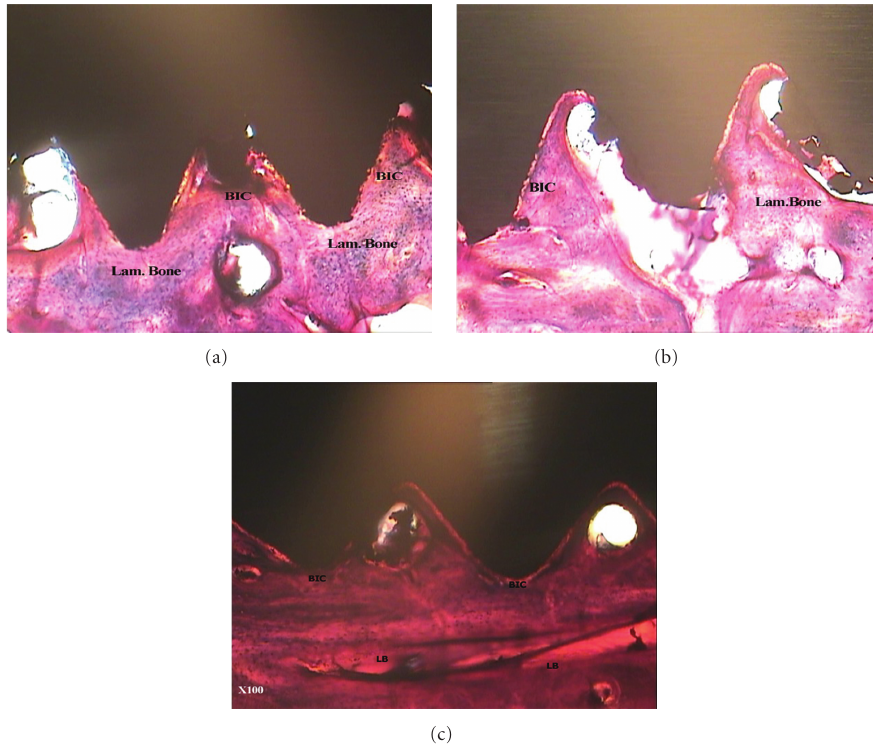
Figure 2: Photomicrographs of bone-to-miniscrew contact in di ff erent groups: (a) immediate orthodontic group, (b) immediate orthopedic group, and (c) control group. Note the quality of bone formation (woven and lamellar) around screws. Masson’s trichrome; original magnification × 100 (BSC: Bone-to-miniscrew contact, L.B: Lamellar bone, W.B: woven bone).